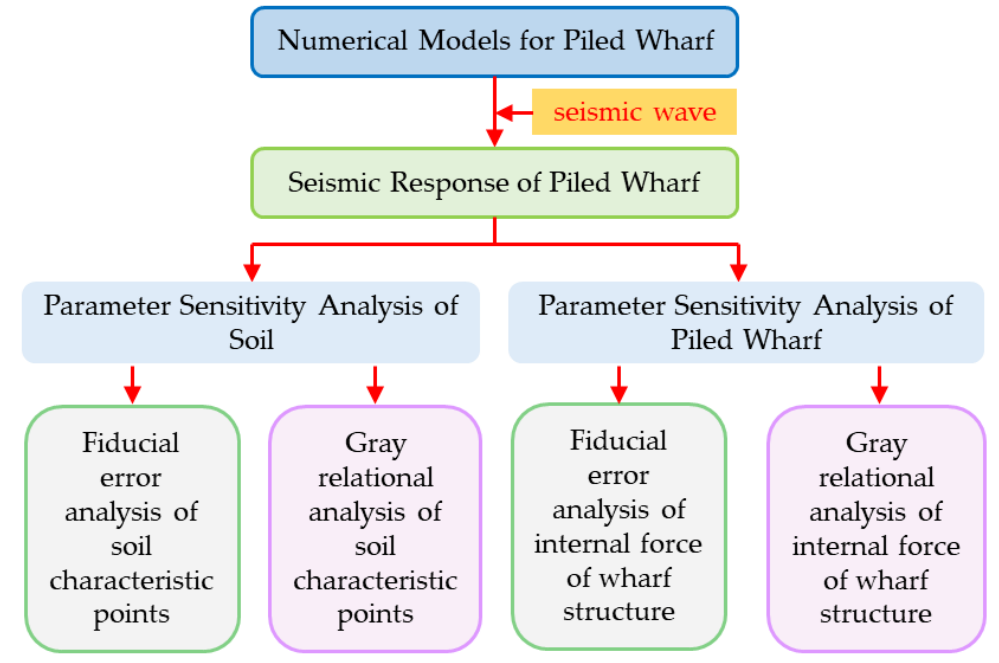
Figure 1. Parameter sensitivity analysis framework flow chart.